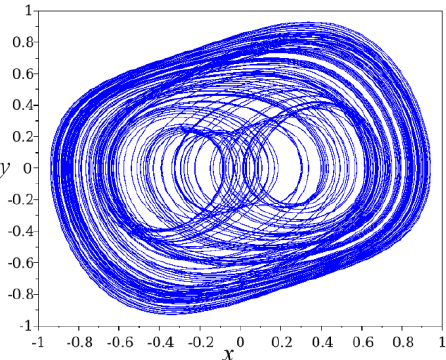
Figure 1. The strange attractor of van der Pol and Duffing mixed type equation [1]. Image credit Yapparina, CC0, via Wiki-media Commons used in accordance with image use policy [2].